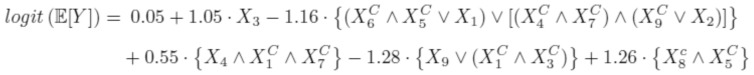
Note: Cen-AA (X1), Cen-BB (X2), IFNL3-G/G (X3), IFNL3-G/T (X4), IFNL3-T/T (X5), HOMOKIR2DL3-C1C1 (X6), HOMOKIR2DL2-C1C1 (X7), HOMOKIR2DL2-C1C2 (X8) viral load less than 400000 UI/ml (X9).